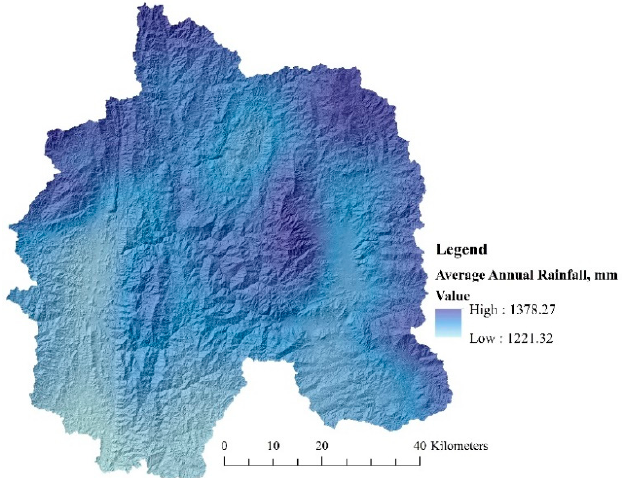
Figure 9. Spatial distribution of mean annual rainfall depth (1981 to 2020).